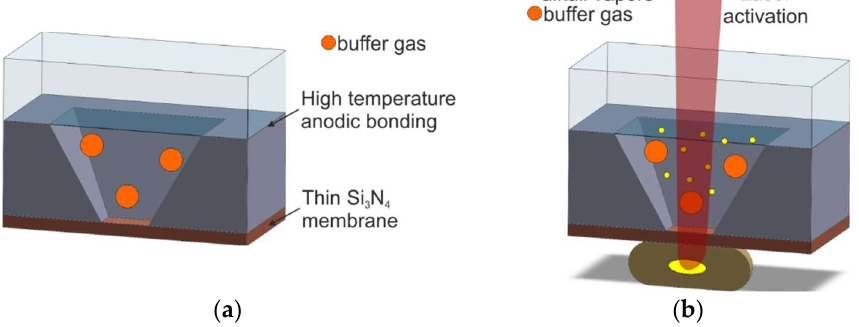
Figure 5. Laser ablation of the silicon nitride membrane and alkali metal introduction: ( a ) cross- sectional view of the MEMS structure, ( b ) laser-induced cesium introduction.